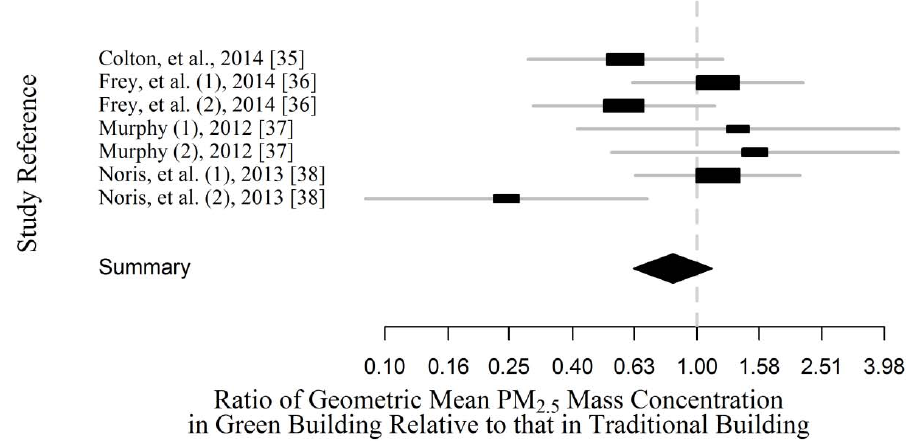
Figure 7. Fixed-effects meta-analysis of studies comparing PM 2.5 in green and traditional multi-family residences. Study labels are author (building if multiple green buildings in one study), year [reference].